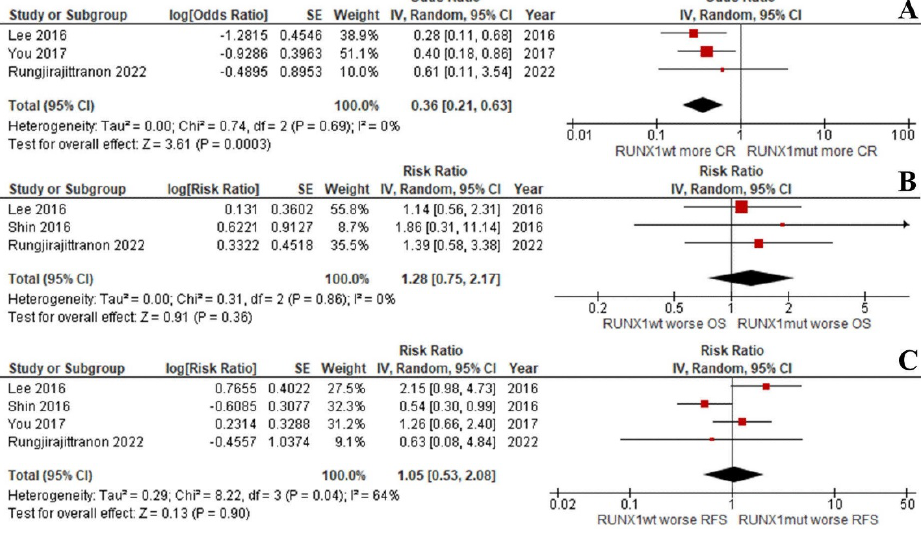
Figure 4. Forest plot of the clinical outcomes of the RUNX1 mut and RUNX1 wt de novo AML patients with intermediate-risk cytogenetics: ( A ) CR rate; ( B ) OS; ( C ) RFS.